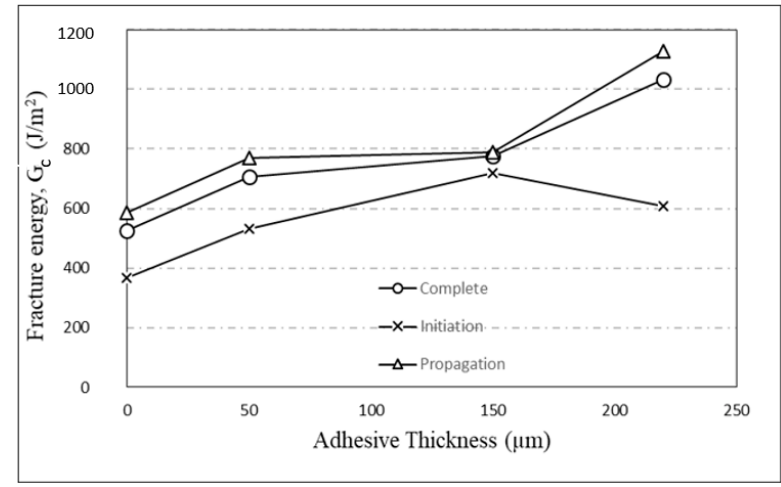
Figure 22. Mixed Mode I/II fracture energy variation with thin film thickness.